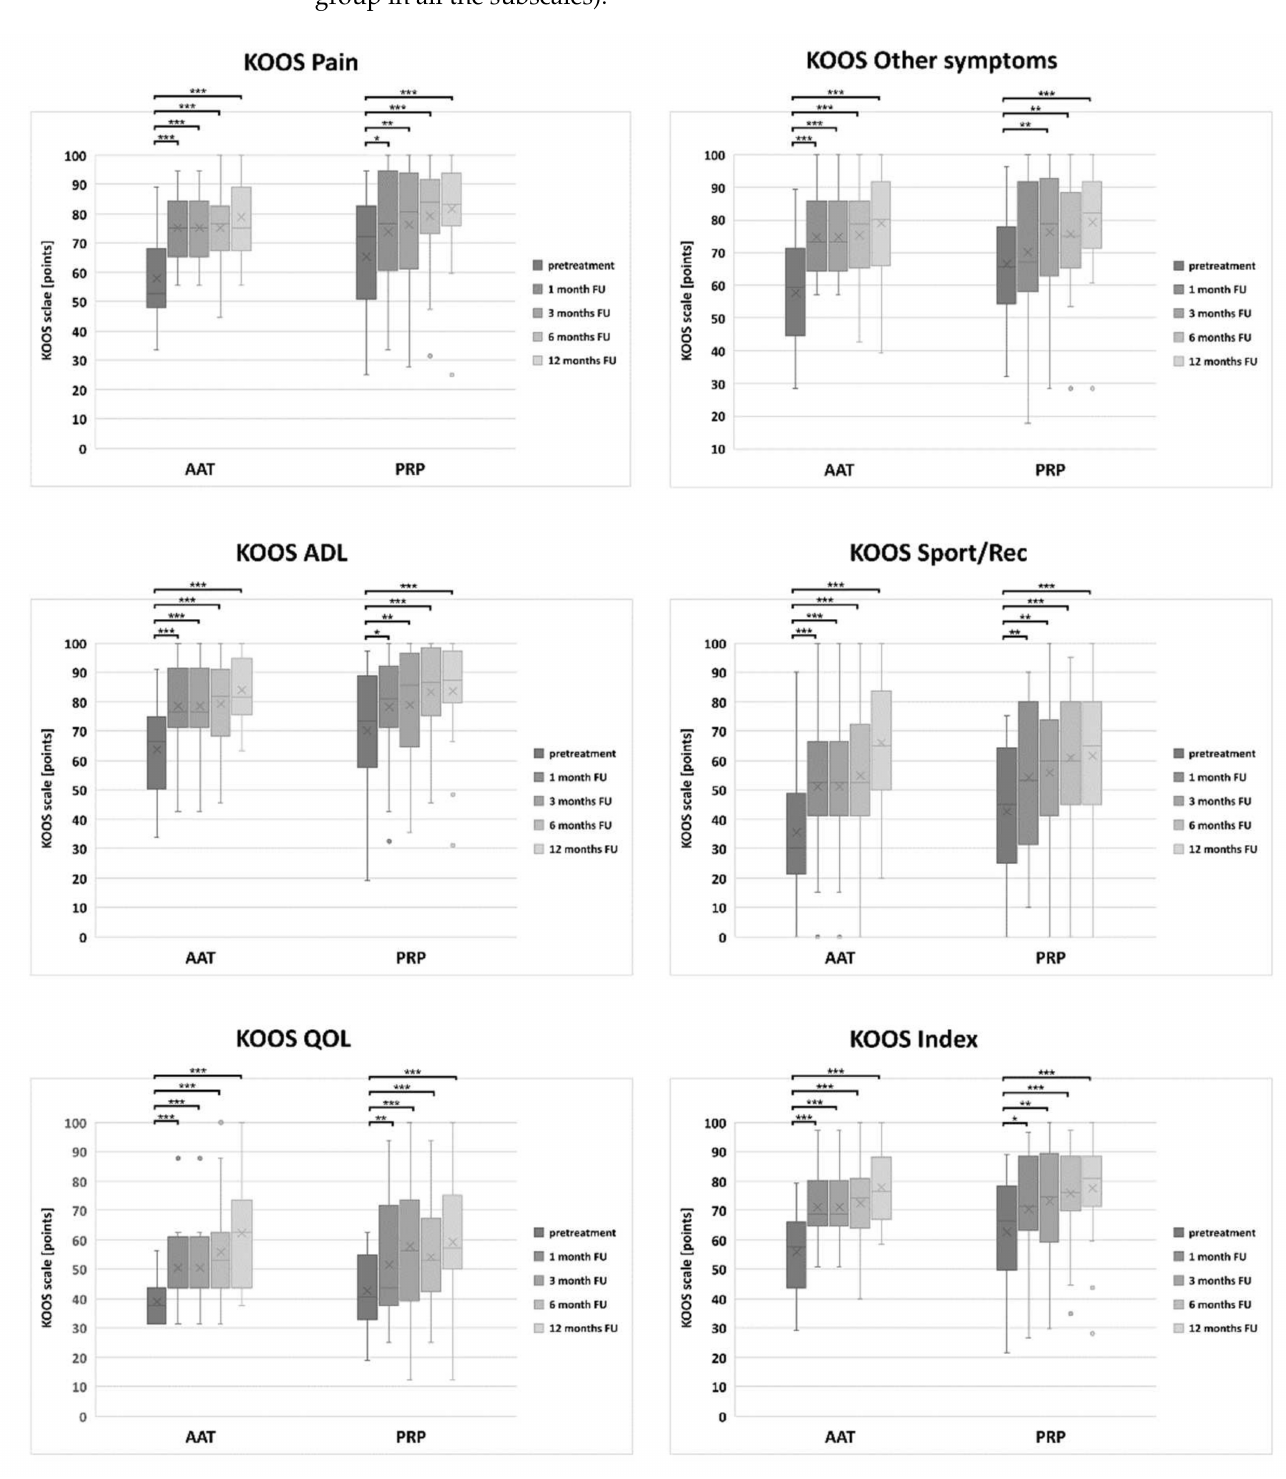
Figure 4. The distribution of the KOOS score values in the PRP and the AAT treatment groups. Central lines represent the medians, boxes indicate the range from 25th to 75th percentile, whiskers extend 1.5 times above the interquartile range and outliers are represented as dots. The significance was designated as * p < 0.05, ** p < 0.01 and *** p <